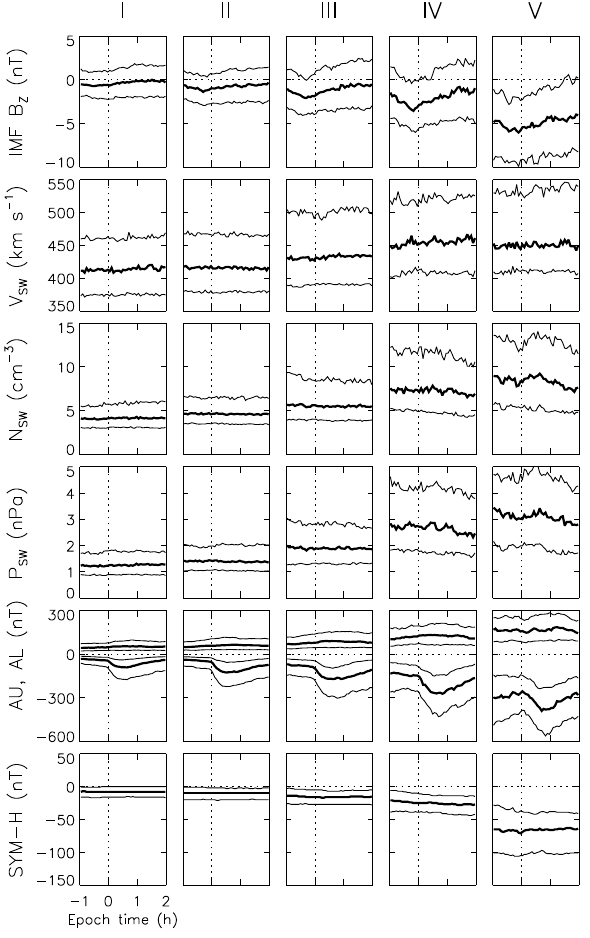
Fig. 6. Superposed epoch analyses of IMF B Z , solar wind velocity V SW , density N SW , and dynamic pressure P SW , the AU and AL indices and SYM-H for the 1993 substorms considered in our study.